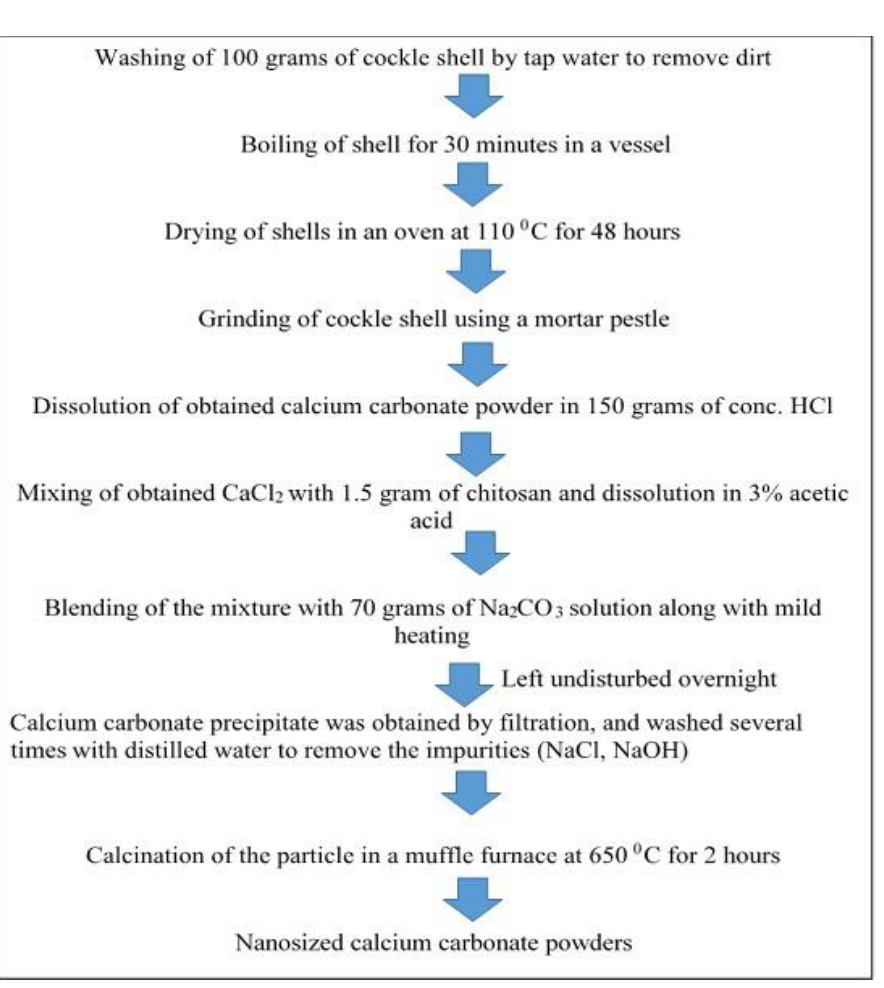
Figure 5. Steps involved in the synthesis of calcium carbonate nanoparticles from cockle shells. Islam et al. (2012) reported an easy, cost-effective, and novel method for the synthesis Figure 6. Aragonite is one of the least abundant biogenic polymorphs of CaCO 3 which is